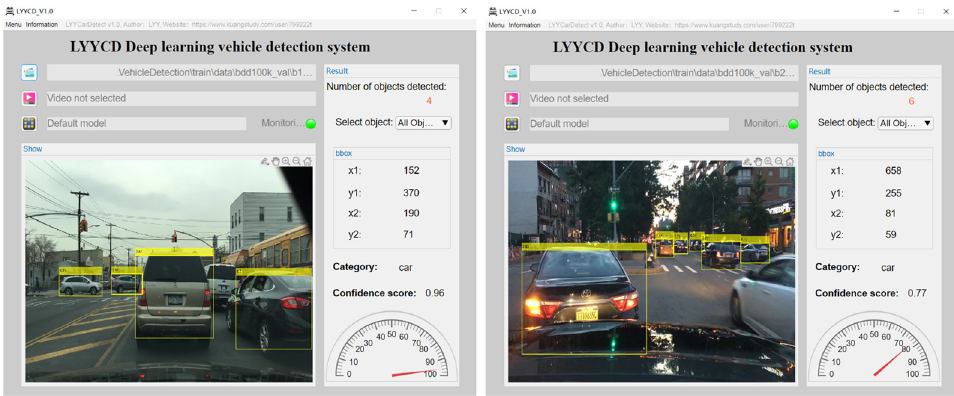
Figure 20. Main interface of vehicle detection system.